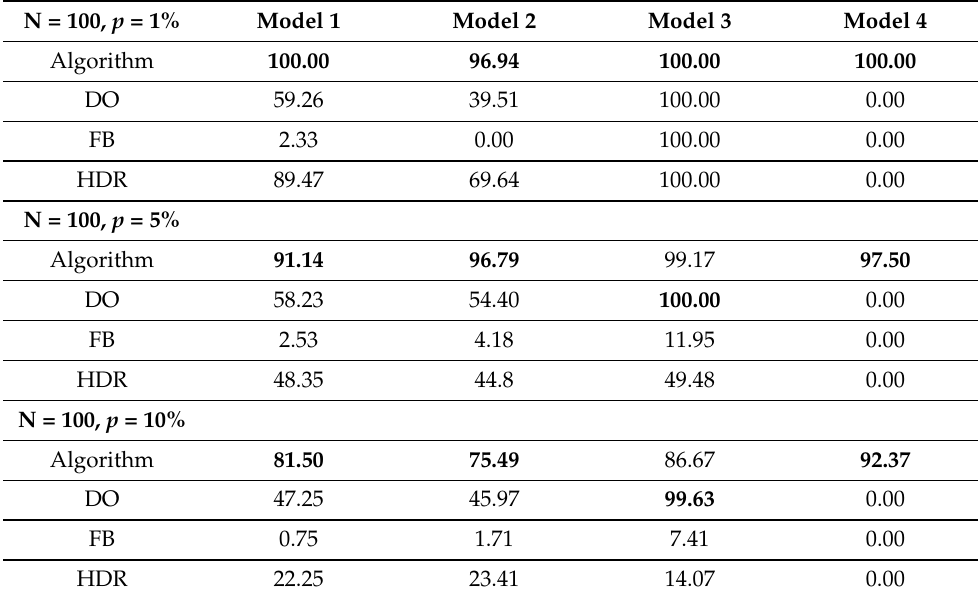
Table 2. Performance of the different algorithms on the test models. The results are expressed as a percentage (detection rates). DO: Directional Detector; FB: Functional Boxplots; HDR: High- Density Regions. The values given in bold correspond to the best results for each